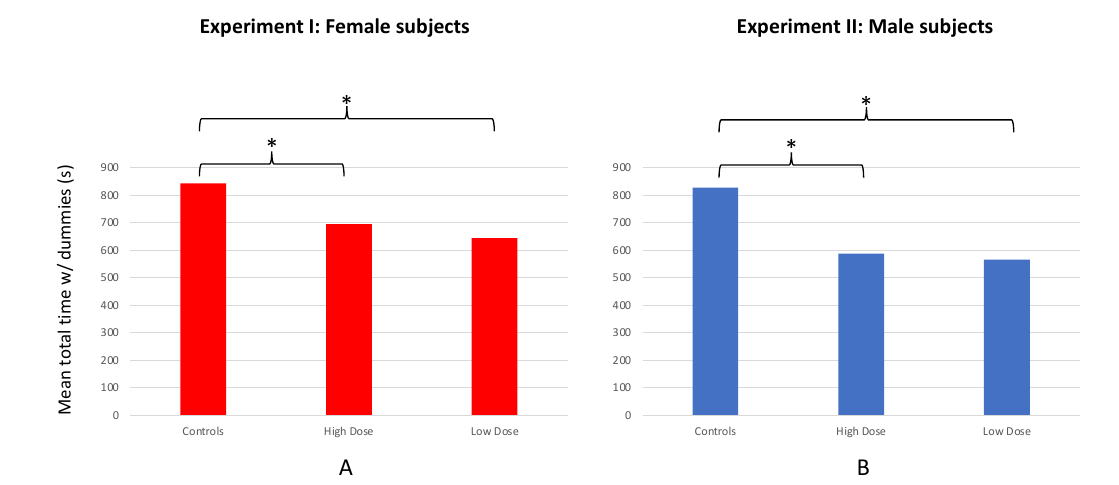
Figure 4. Comparison of mean time low dose, high dose, and control females from expt. I ( A ) and males from expt. II ( B ) spent with both stimuli combined. Starred brackets (*) indicate a significant difference between the treatment groups in mean time spent with both dummies combined (paired samples t ‐ tests).